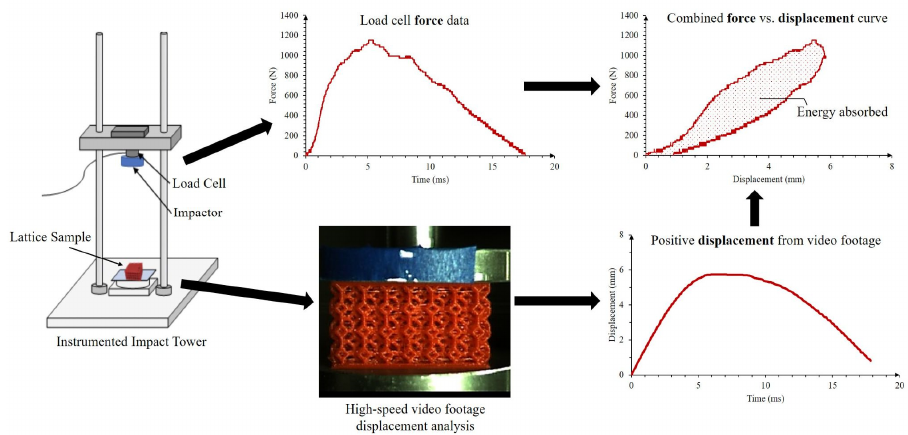
Table 4. Height, energy, and velocity of the experimental impact events.